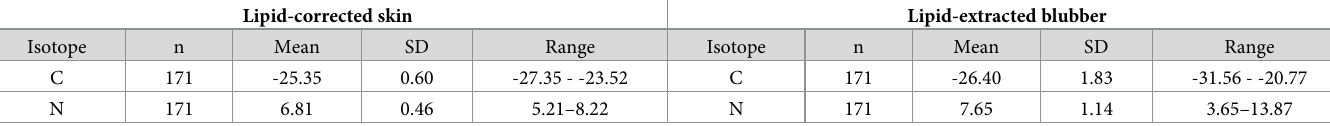
Table 1. Table overview of the mean, standard deviation (SD) and range for δ 13 C and δ 15 N values for lipid-extracted blubber and lipid-corrected skin tissue of E1 humpback whales (n =